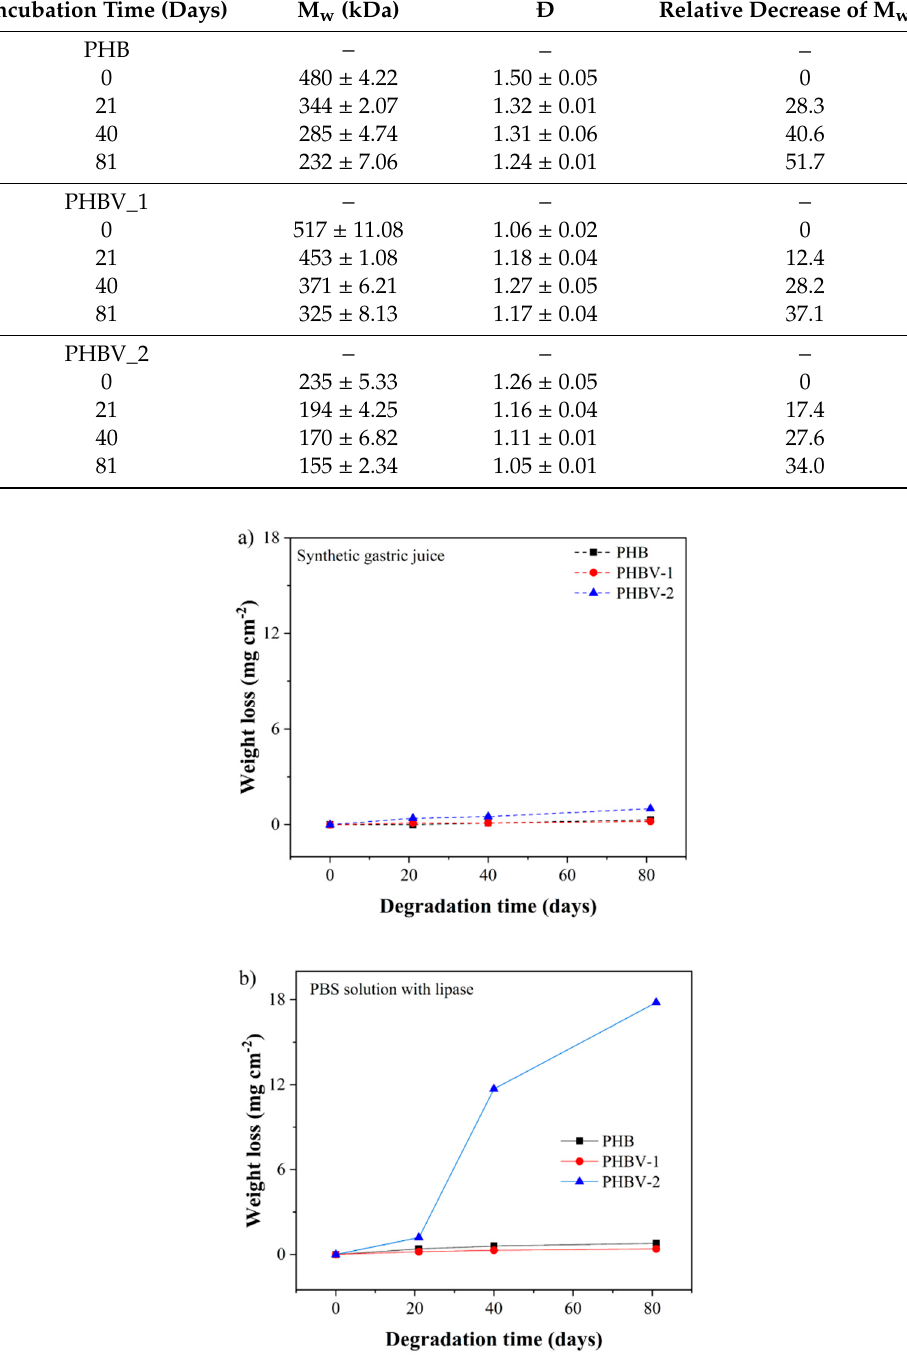
Figure 7. Degradation of PHB, PHBV-1, and PHBV-2 at 37 ◦ C in ( a ) synthetic gastric juice and ( b ) phosphate bu ff er saline solution with